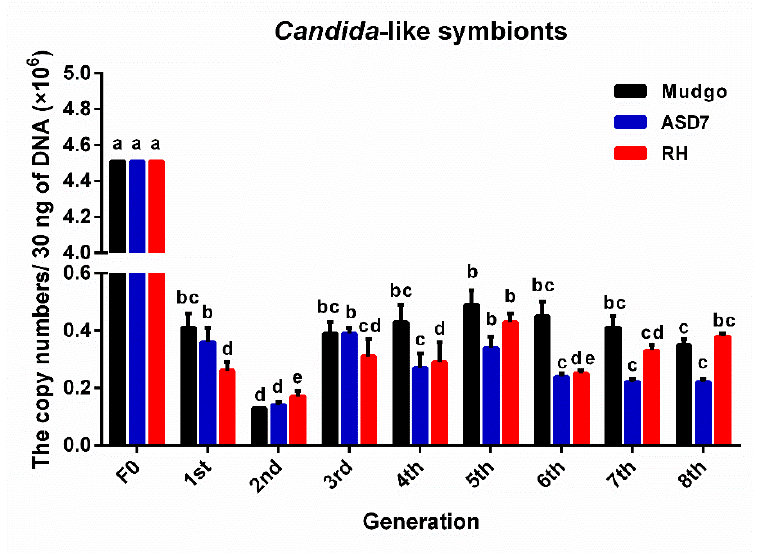
Figure 6. The copy number (×10 6 ) of Candida -like symbionts of BPH cultivated on three BPH-resistant rice varieties. The F0 generation is BPH raised on TN1 rice. There were significant differences between different lowercase letters ( p ≤ 0.01, one-factor ANOVA, and Tukey’s multiple comparisons).